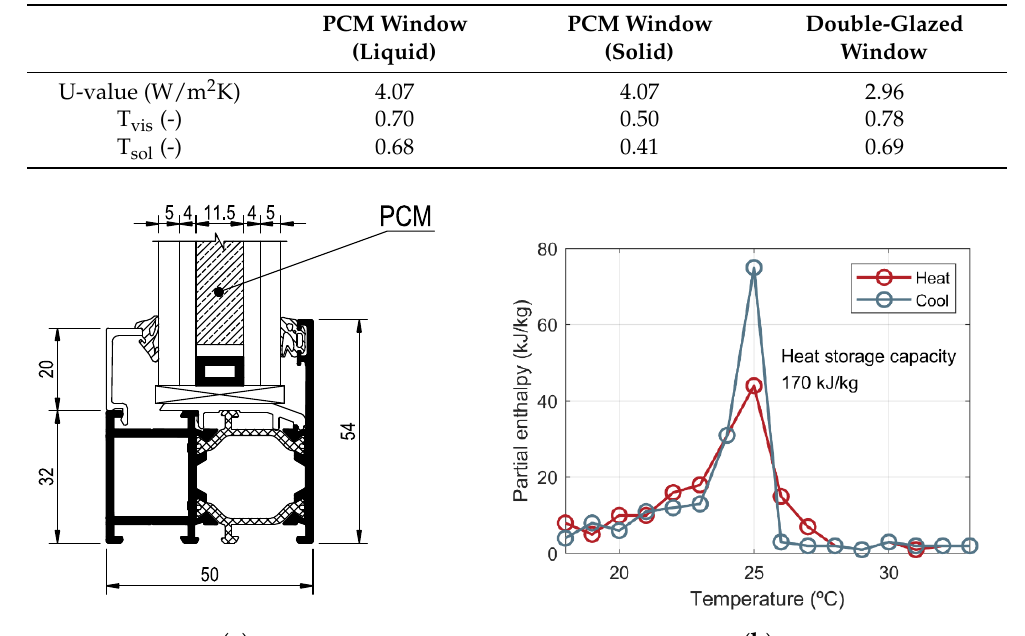
Figure 2. ( a ) window dimensions (mm); ( b ) partial enthalpy of paraffin RT25. Table 1. Thermophysical properties of the PCM window and double-glazed window.